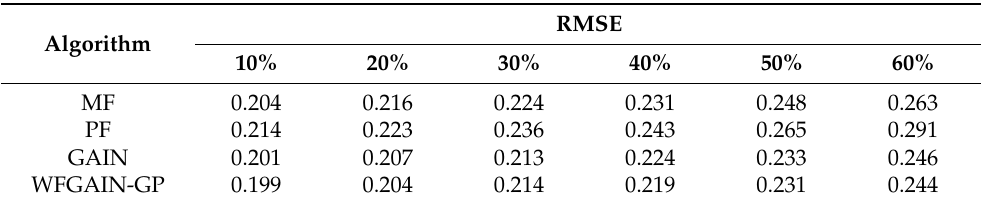
Table 6. RMSE values of the imputation results for each model at different missing rates. Root Mean Squared Error (RMSE) is a measure of the average difference between predicted and actual values, expressed in the same units. It is commonly used to compare the predictive accuracy of different models.